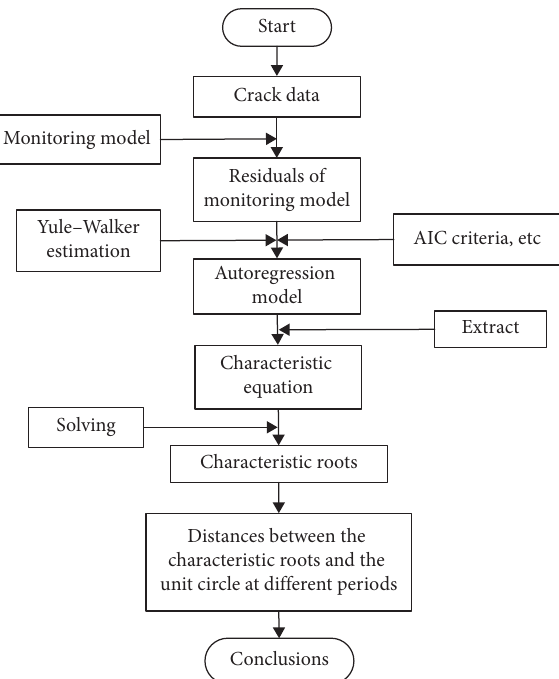
Figure 1: Flow chart of the unit root analysis